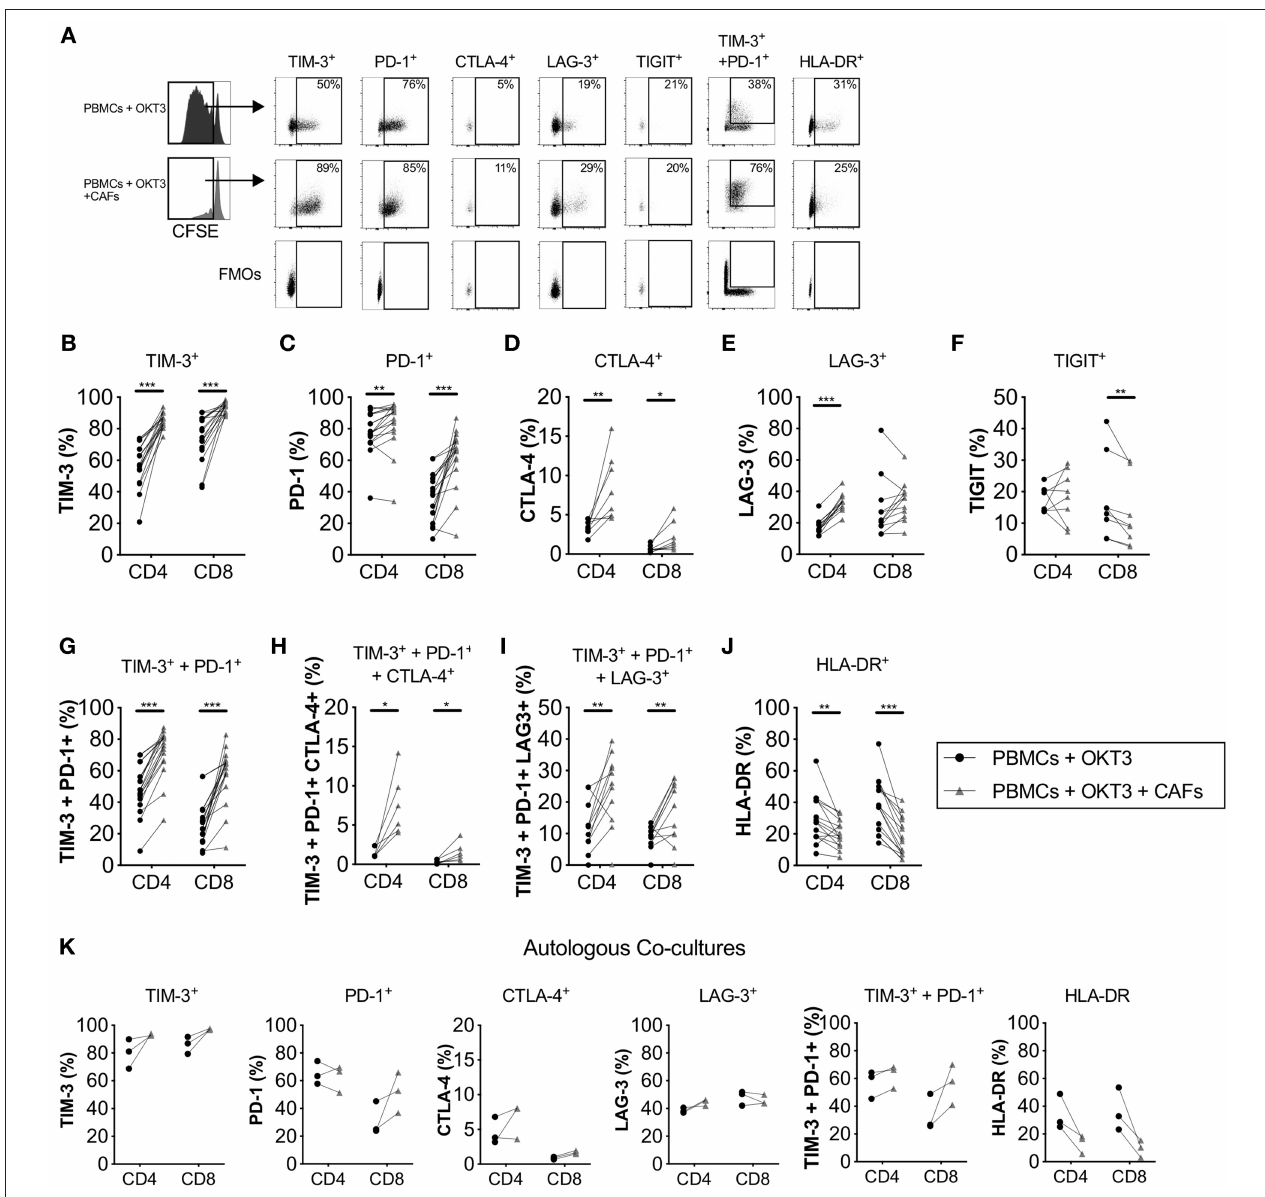
FIGURE 3 | CAFs promote the expression of co-inhibitory markers on proliferating T-cells. CFSE-labeled PBMCs were co-cultured in the absence (•) or presence ( N ) of CAFs and stimulated with OKT3 (25ng/ml) for 5 days. (A) Representative flow cytometry dot plots on proliferating CD4 + T-cells showing the expression of different molecules after stimulation in the presence or absence of allogeneic CAFs. Expression of (B) TIM-3 ( n = 18), (C) PD-1 ( n = 18), (D) CTLA-4 ( n = 8), (E) LAG-3 ( n = 12), (F) TIGIT ( n = 8), (G) co-expression of TIM-3 and PD-1 ( n = 16), (H) co-expression of TIM-3, PD-1 and CTLA-4 ( n = 6) and (I) co-expression of TIM-3, PD-1 and LAG-3 ( n = 12), and (J) HLA-DR ( n = 18) on proliferating CD4 + and CD8 + T-cells in the absence (•) or presence ( N ) of allogeneic CAFs. (K) Co-inhibitory markers on patient-derived CD4 + and CD8 + T-cells in the absence or presence of autologous CAFs ( n = 3). (A–J) The bars indicate the median. (K) Lines between dots indicate pared samples. Wilcoxon matched-pairs signed rank test was used to detect statistically significant differences, * P < 0.05, ** P < 0.01, *** P <